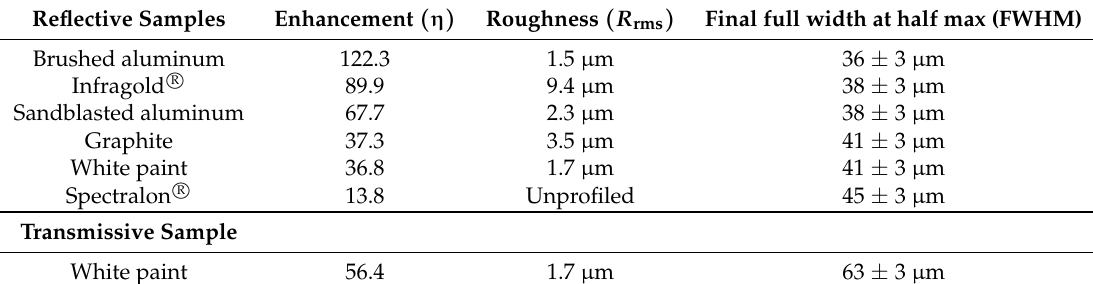
Table 1. Summary values of enhancement, surface roughness and spot size for each of the six reflective samples measured and the one transmissive